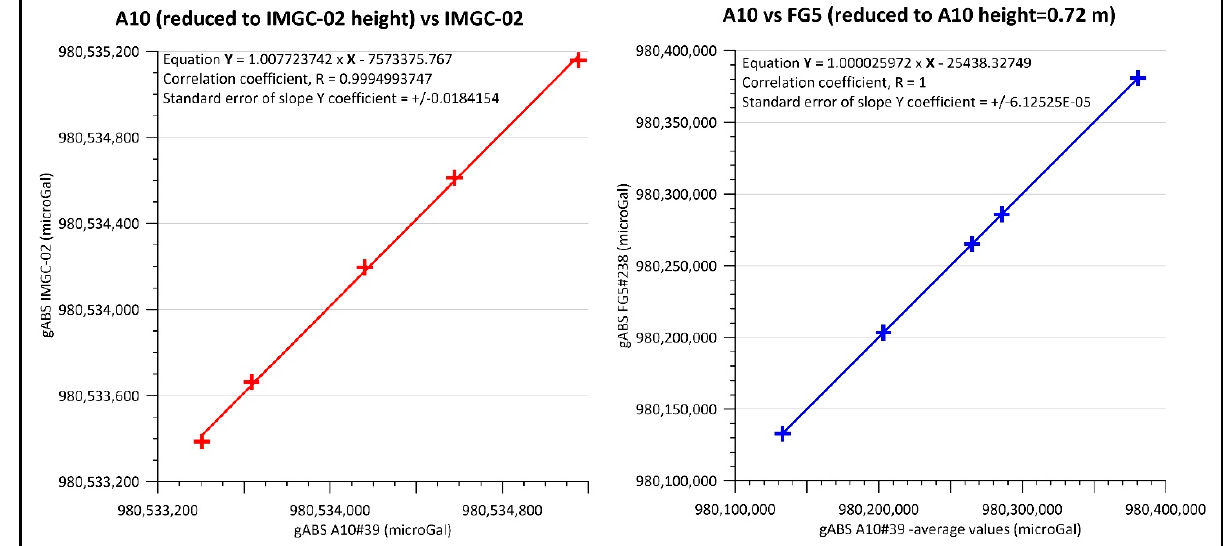
Figure 3. ( Left ): Linear regression between A10#39 and IMGC02 gravity values at the 5 measured stations at the INRiM laboratories over a gravity excursion of approximately 2 mGal (2000 µ Gal). The comparison was performed reducing the average A10#39 values to the measurement heights of IMGC-02; ( Right ): Linear regression between A10#39 and FG5#238 gravity values at the 5 measured stations of central Italy network over a gravity excursion of approximately 250 mGal (250,000 µ Gal). Error bars are within the symbols size.